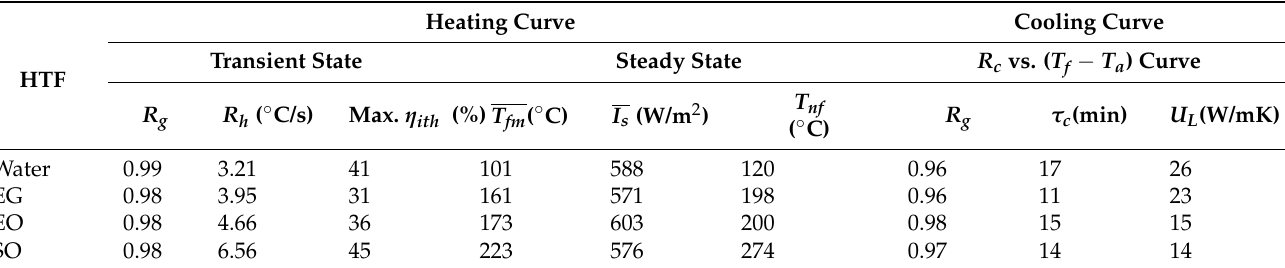
Table 5. HTF heating and cooling